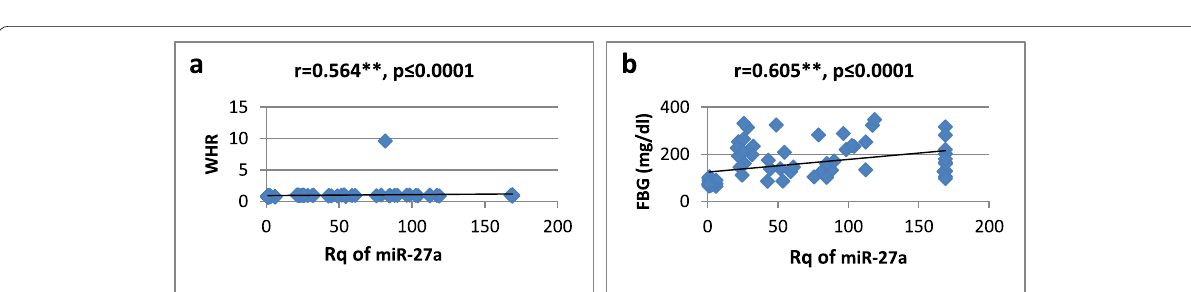
Fig. 4 a , b Correlation coefficient between Rq of MicroRNA 27‑a and both WHR ( r p